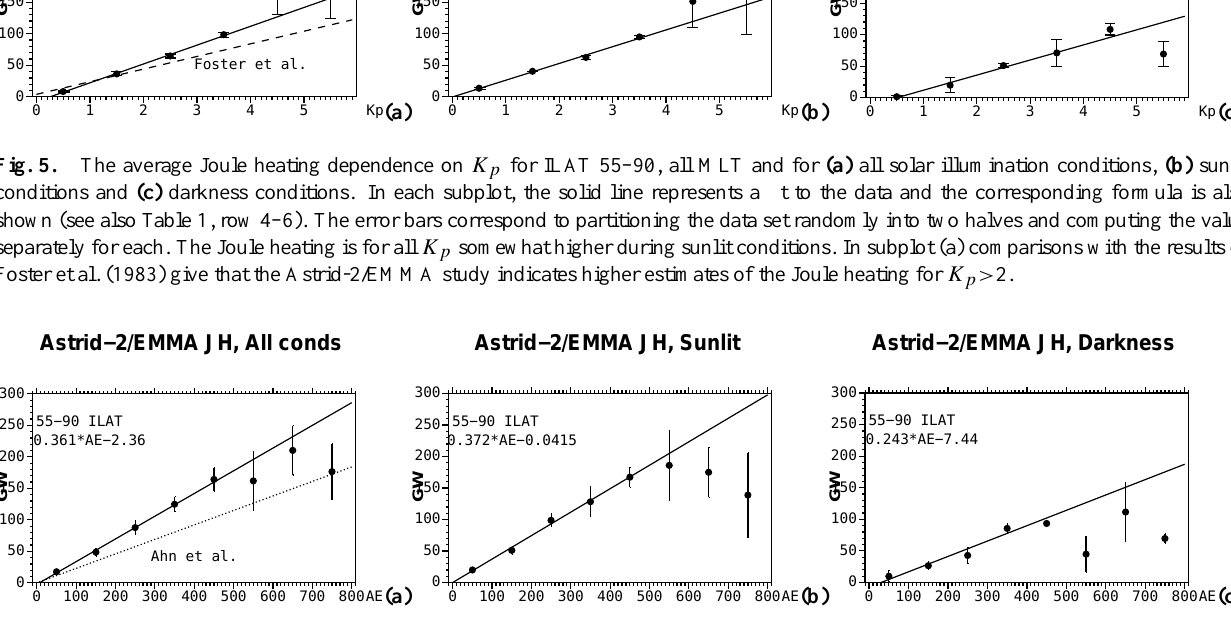
Fig. 6. Same as Fig. 5 but for AE indexes. The Joule heating is almost twice as high for sunlit conditions compared to darkness. At AE values above ∼ 400 an interesting saturation of the Joule heating occurrs. In subplot (a) comparisons with the results of Ahn et al. (1983) (dotted line) is shown. For all K p the Joule heating estimates from Astrid-2/EMMA are always higher than the radar estimates by Ahn et al. (1983).